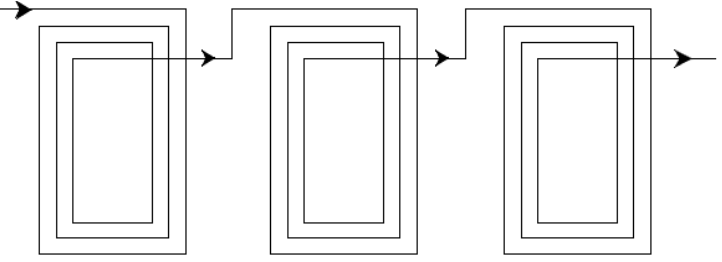
Figure 8. Single-phase concentric winding.